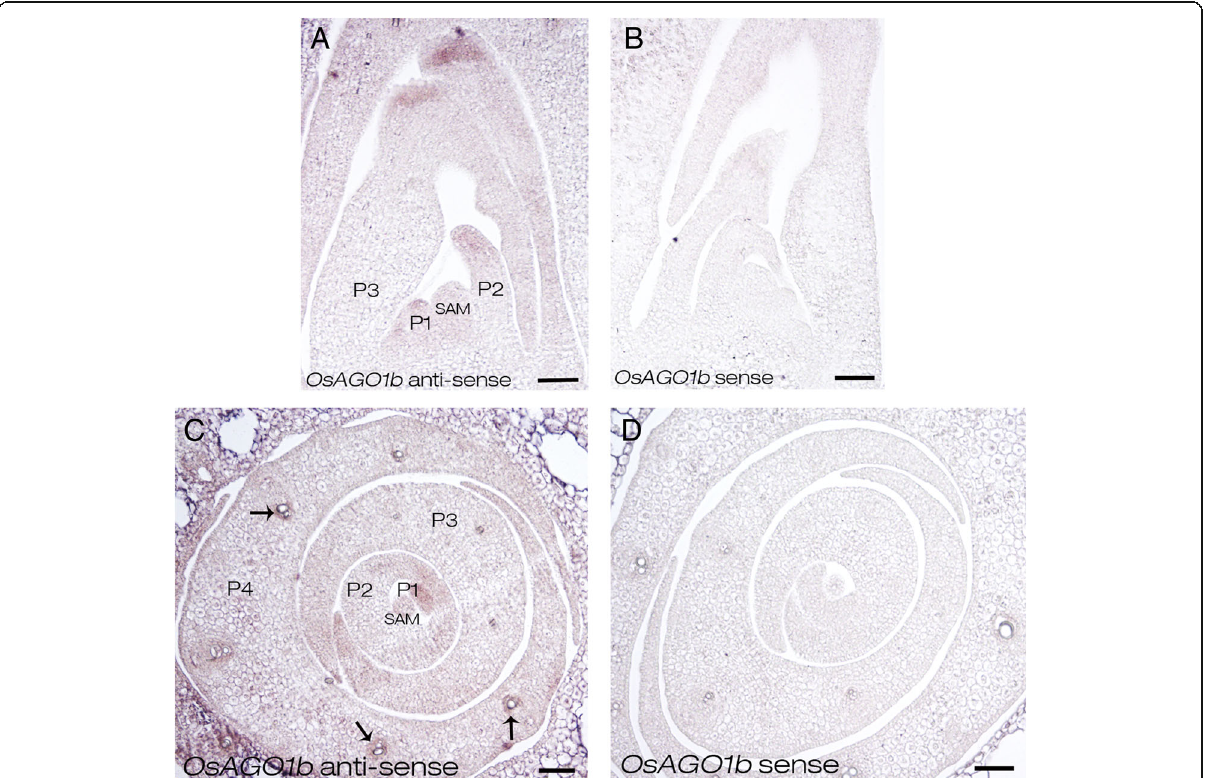
Fig. 7 In situ hybridization of OsAGO1b in the vegetative shoot apex in ZH11. a and c In situ hybridization of OsAGO1b in ZH11 using anti-sense probe. b and d In situ hybridization of OsAGO1b in ZH11 using sense probe. Shoot base cuttings about 1cm in length including SAM of 14-day-old seedlings were used. a - b Longitudinal sections of 14-day-old seedlings. c - d Cross sections of 14-day-old seedlings. SAM, shoot apical meristem; P1, P1 leaf primordium; P2, P2 leaf primordium; P3, P3 leaf primordium. Black arrows indicate the developing vasculars. Scale bars=50 μ